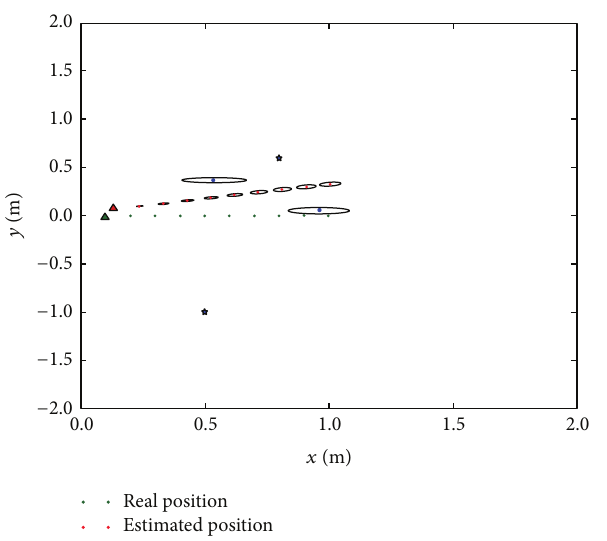
Figure 11: The experiment motion result of Robot SLAM with closed-loop controller and avoidance